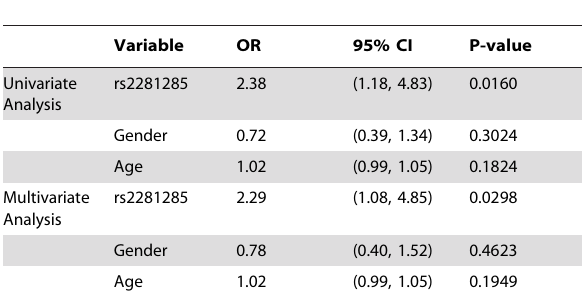
Table 2. Univariate and multivariate logistic regression results in the replication (German) sample, examining the relationship between negative craving, rs2281285, age, and